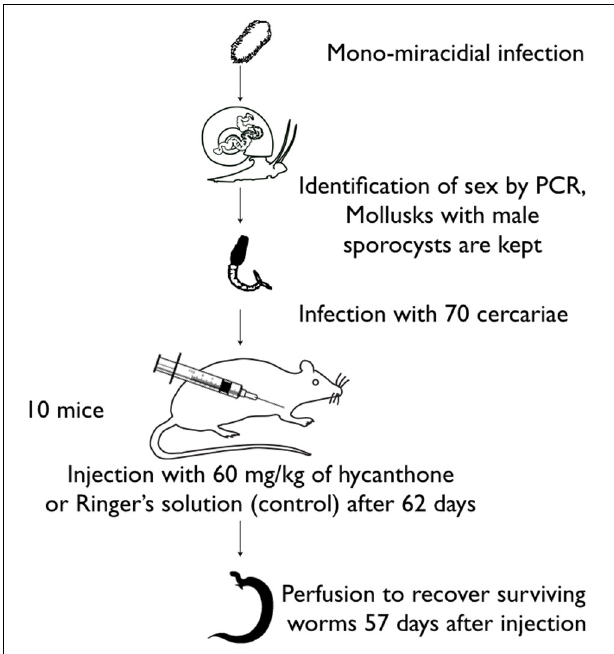
FIGURE 1 | Graphical abstract of the methodology used for the Lederberg-like experiment.